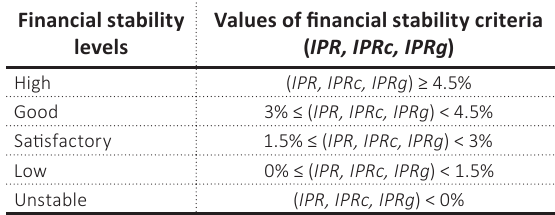
Table 1. Qualitative assessment criteria of financial